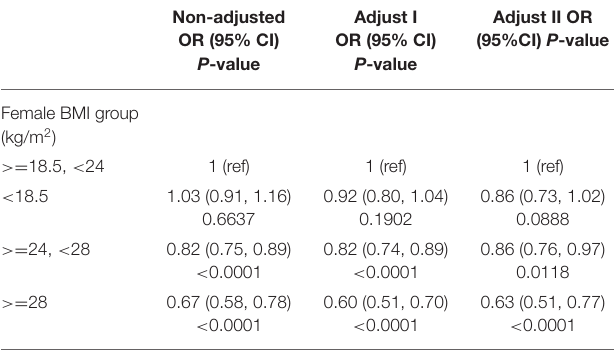
was BMI (red dots). The blue dotted lines are the 95% confidence intervals. The right model was adjusted for treatment year, patient’s age, AFC, basal FSH, smoking habits, type